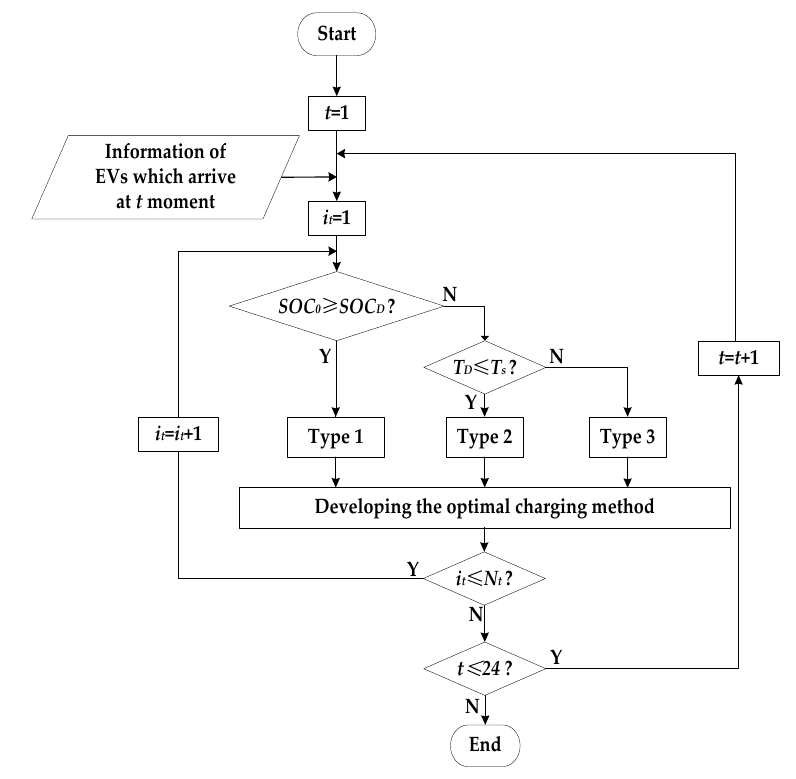
Figure 10. Flow chart of optimal charging method.